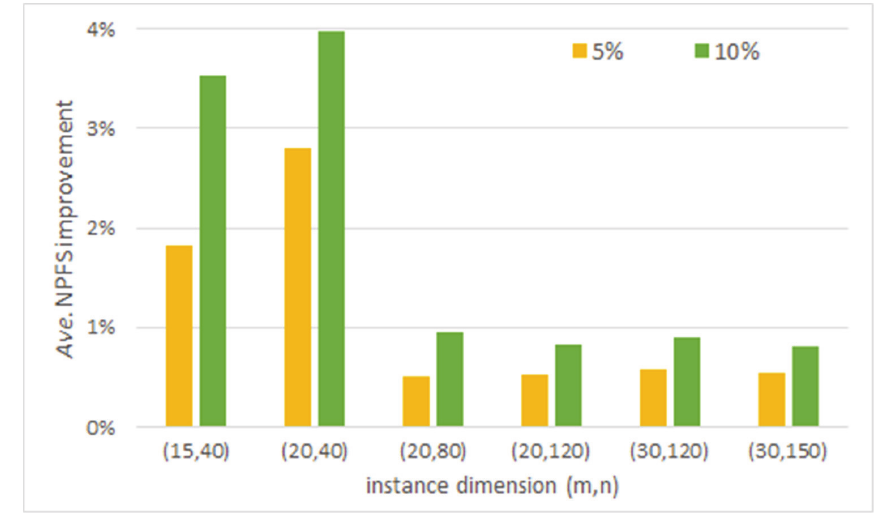
Fig. 3 . Ave. NPFS improvements, considering 5% and 10% of zero values in the processing